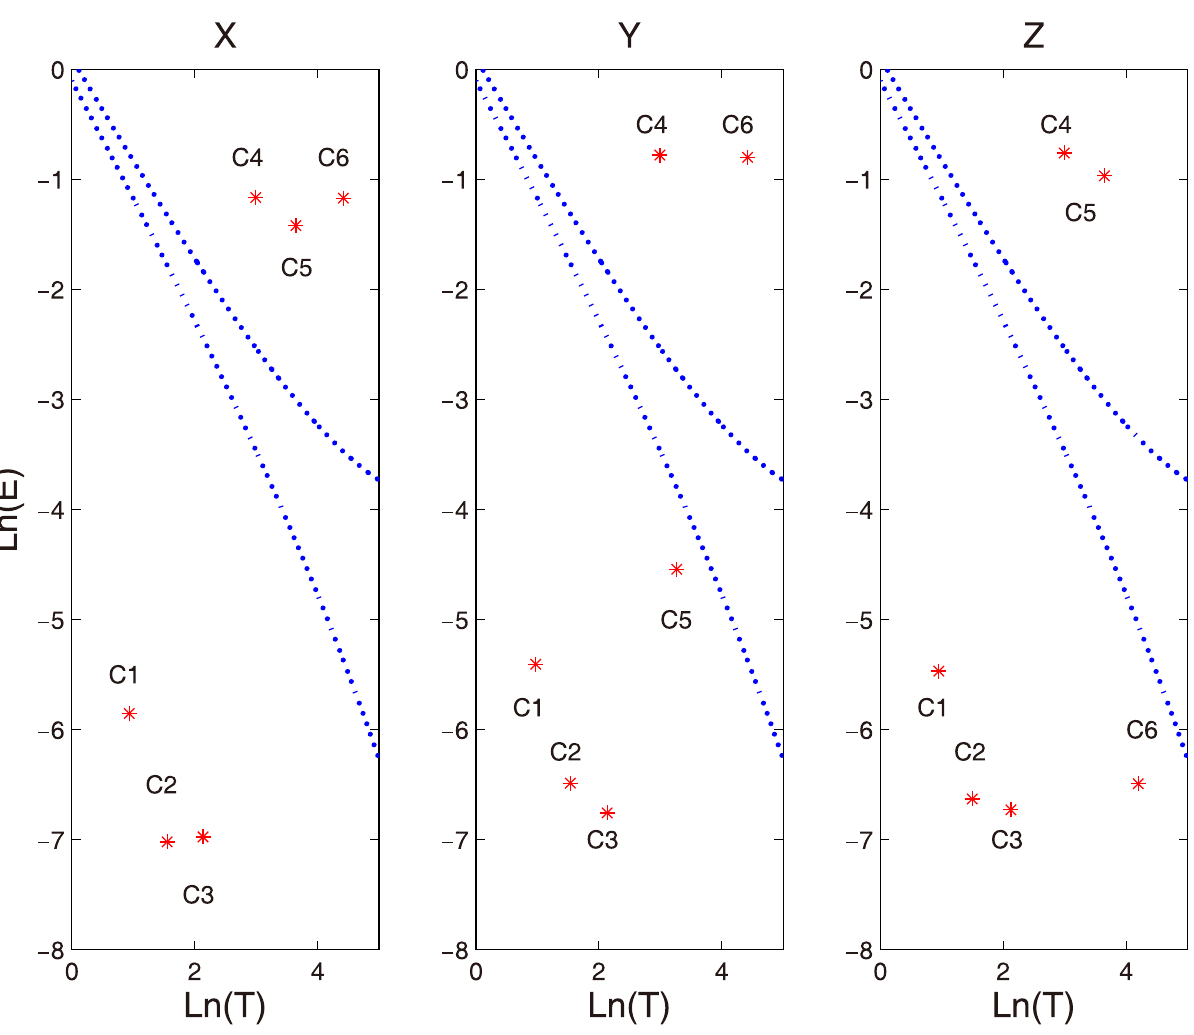
Figure 3. Statistical significance of first six IMFs for synthetic time series [X Y Z] by MEMD based on the method in [12]. In each panel, the energy of IMFs is plotted as a function of the logarithm of period, where the two dotted curves indicate 95% confidence intervals, corresponding to the upper and lower boundaries of the energy spread function, and each symbol ‘*’ refers to an IMF. The false identifications frequently occur in all three channels, e.g. all IMFs are identified significant in three channels.